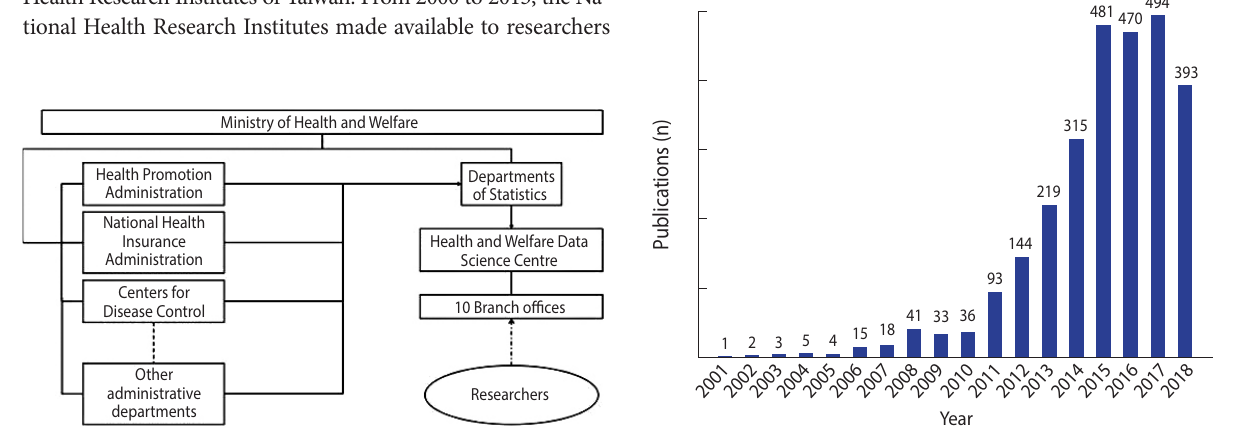
Figure 1. Administrative structure of the National Health Insurance Research Database